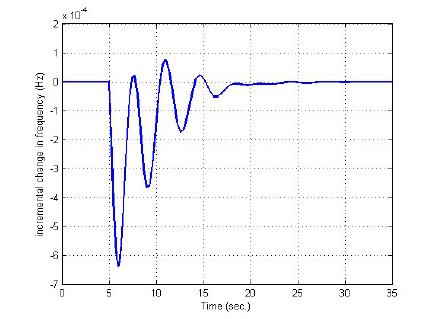
Fig. 2: Frequency deviation of area-1 (Case 1)